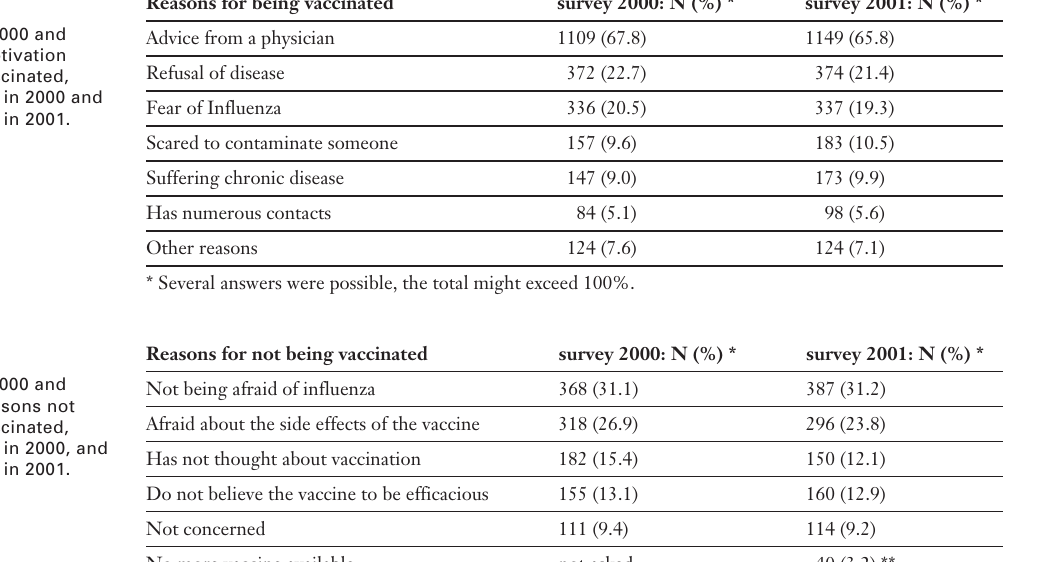
Survey 2000 and 2001: motivation to be vaccinated, N = 1636 in 2000 and N = 1746 in 2001.